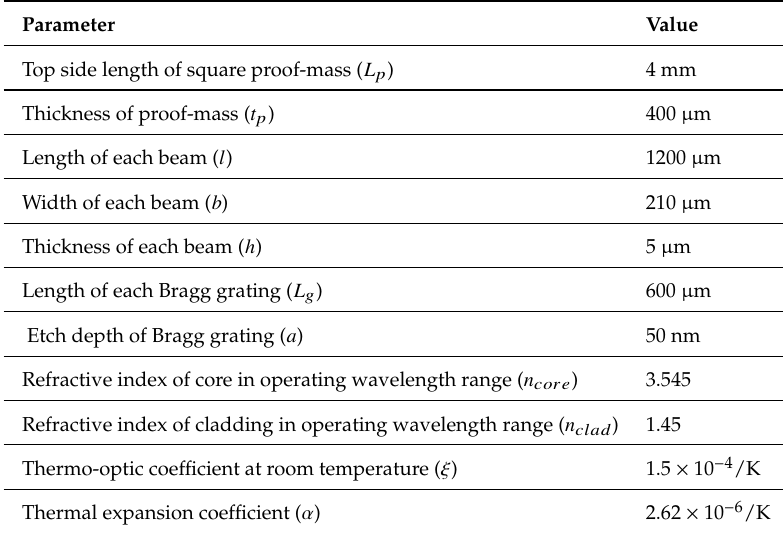
Table 2. Device dimensions and material